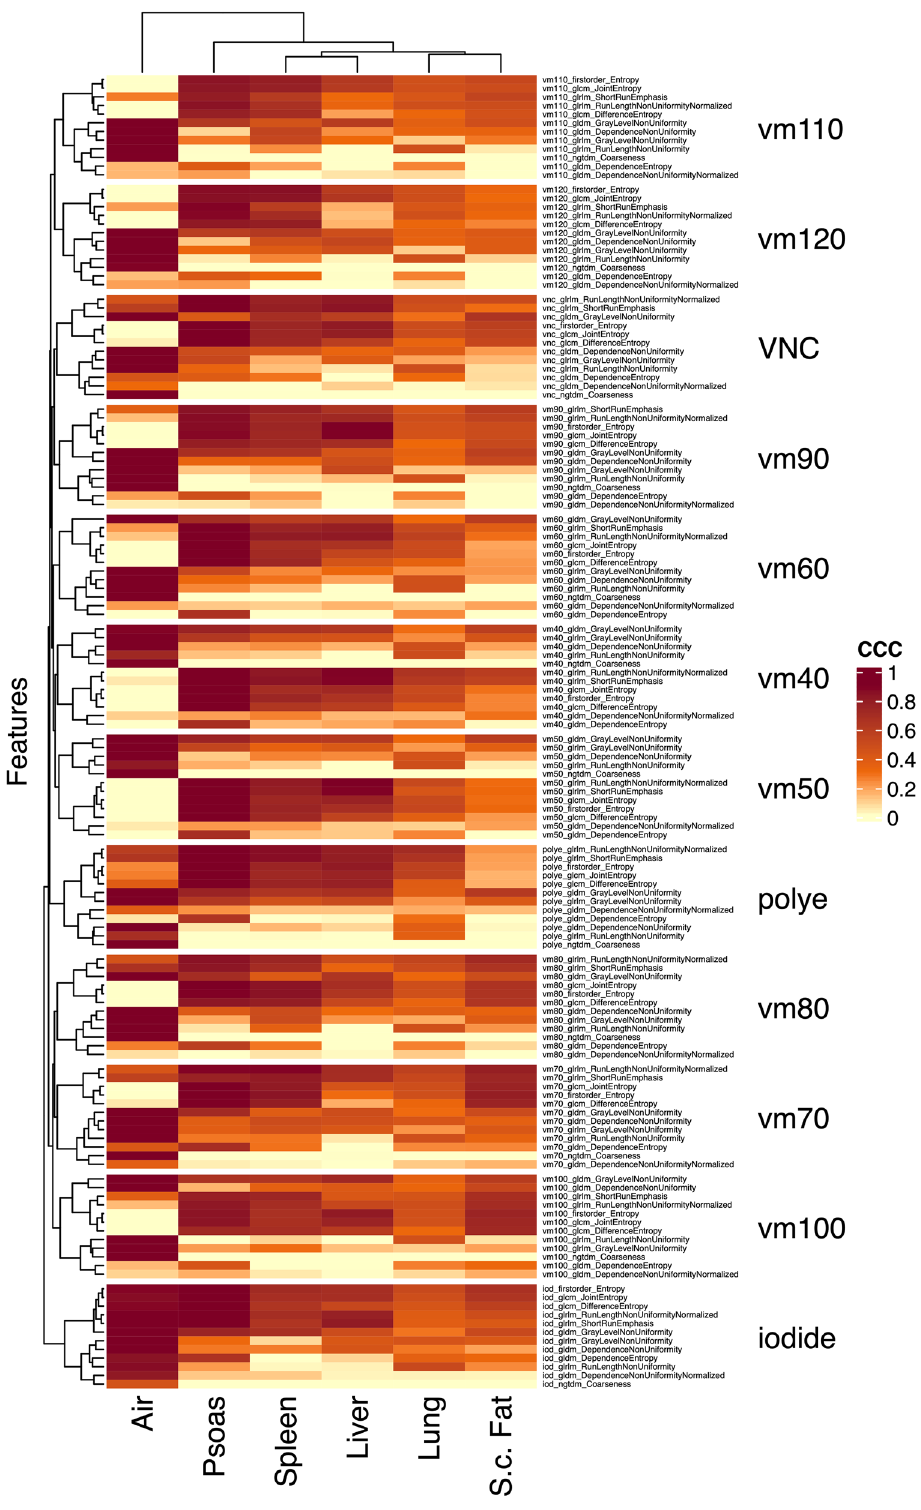
Figure 5. Concordance Correlation Coefficient for segmentation–resegmentation stability in 3D-2 cm segmentations, split by